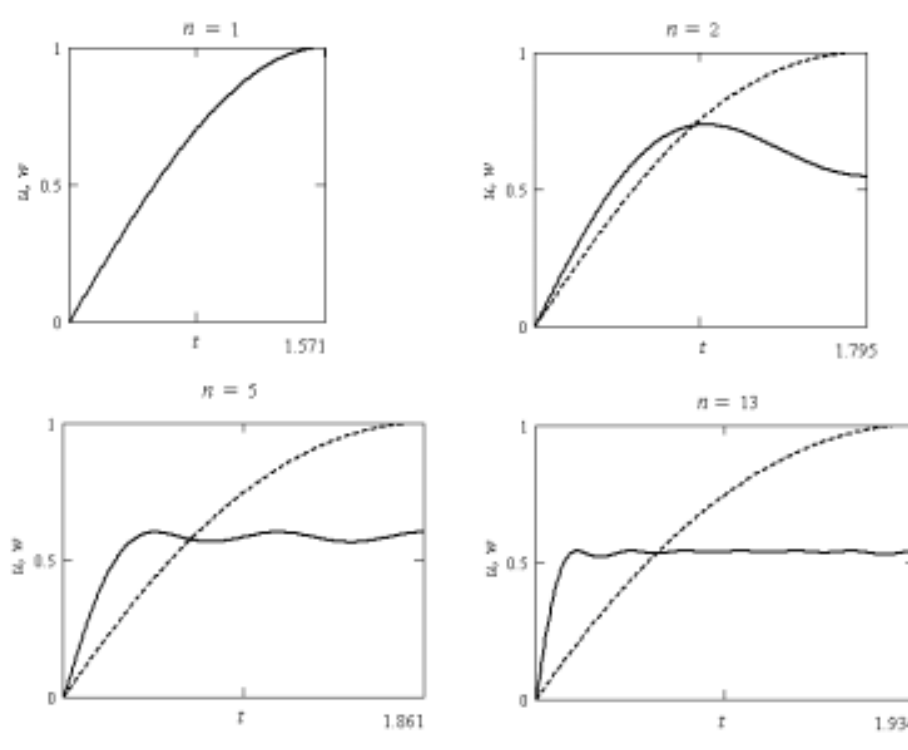
Fig. 4. Normalized relative displacement and deceleration time histories for the optimal linear elastic-inertial shock isolation systems. Dashed lines – displacement, solid lines –